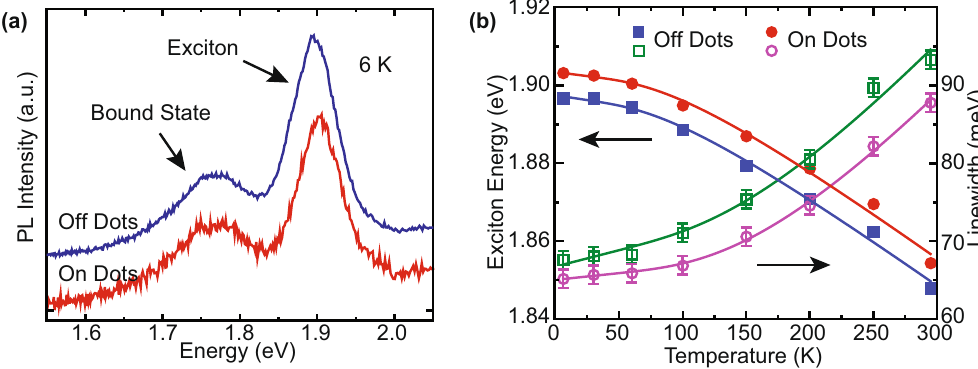
Figure 3. PL spectra characterization. ( a ) The PL of the nanodots (red) and continuous ML (blue) at 6 K both show features of excitonic and low-energy bound state emission. ( b ) Temperature dependence of the exciton energy E ex (solid) and linewidth Γ (empty) for nanodots (circles) and ML (squares). The lines are fits to the Manoogian-Wooley equation 62 and Eq. (2),